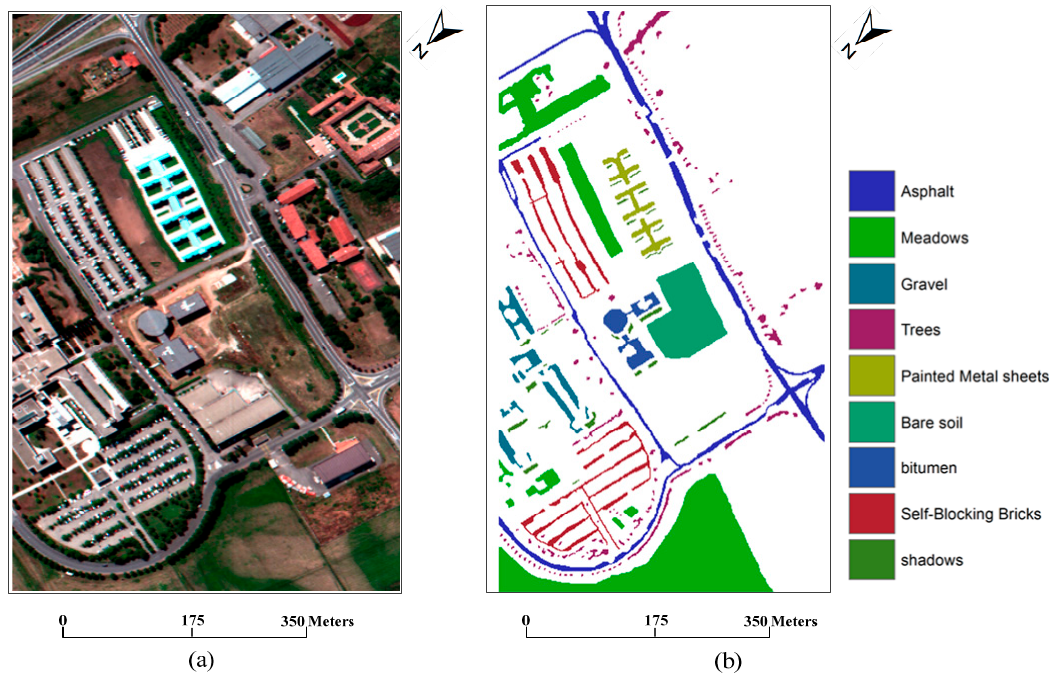
Figure 6. Second study area: ( a ) scene of Pavia University acquired by ROSIS-03; ( b ) ground reference of Pavia University.